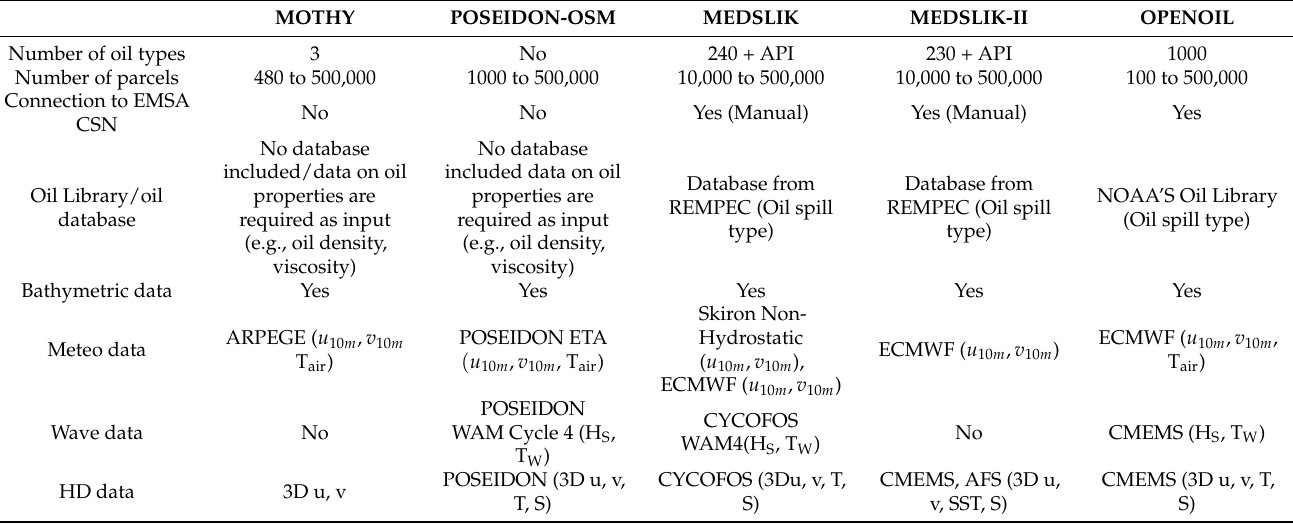
Table 3. Oil spill models general information and input data (adapted from MEDSESS-EMS,